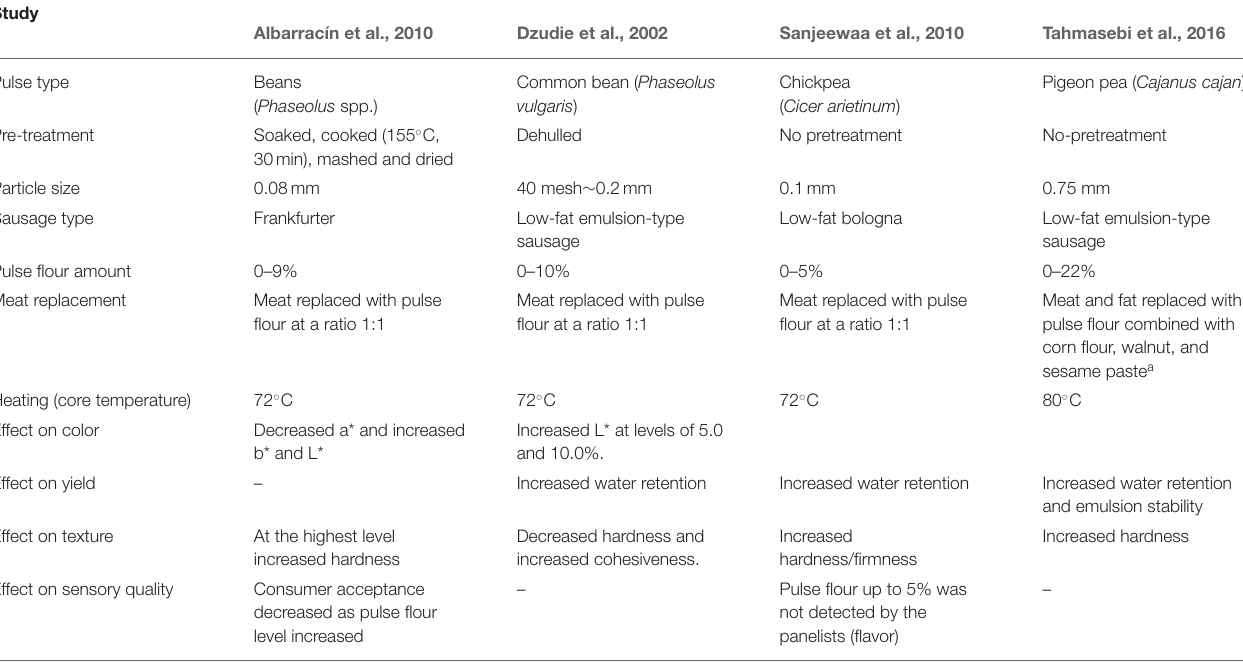
TABLE 2 | Methodology and results from studies testing the effect pulse flours on the quality of emulsion-type sausages.